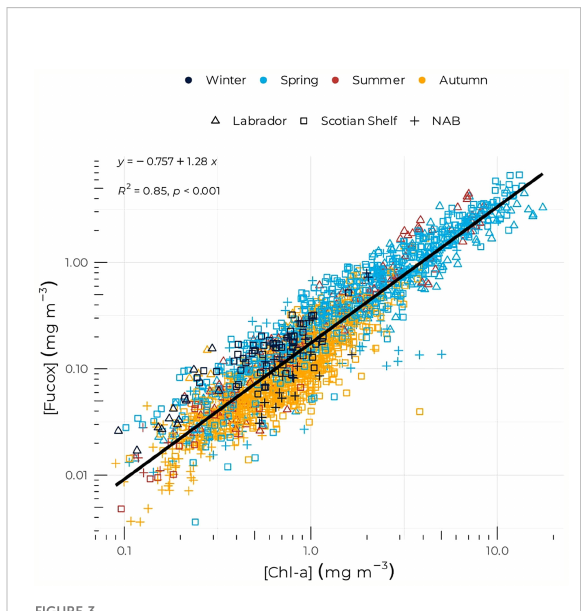
FIGURE 3 [Fucox] as a function of [Chl-a]. Symbols are color-coded according to season as in Figure